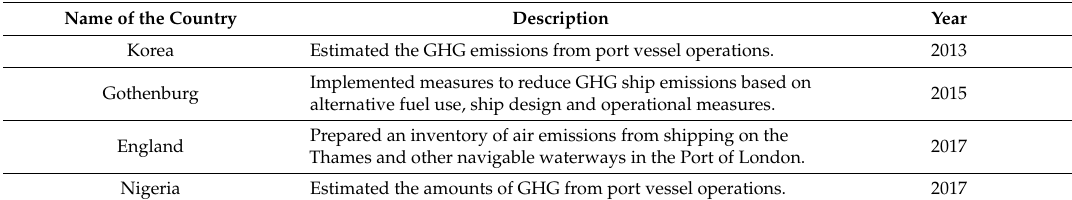
Table 5. Existing methodologies related to